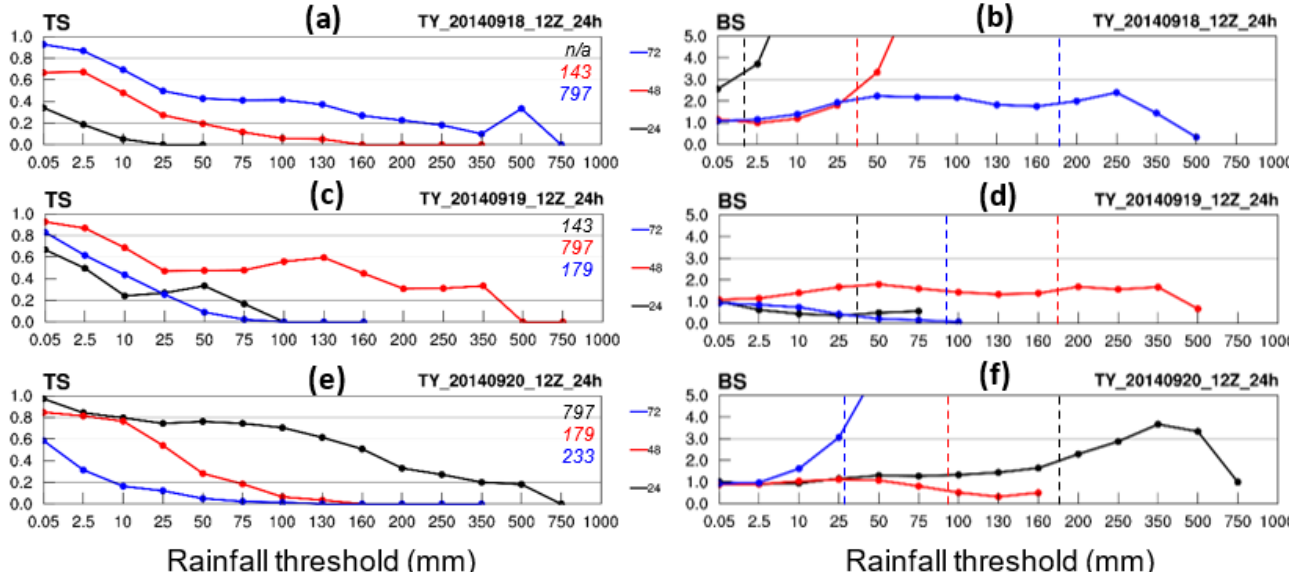
Figure 8. As in Figure 5, except for TS and BS of CReSS 24 h QPFs from the forecast made at 1200 UTC of ( a , b ) 18, ( c , d ) 19, and ( e , f ) 20 September, respectively, during TY Fung-Wong